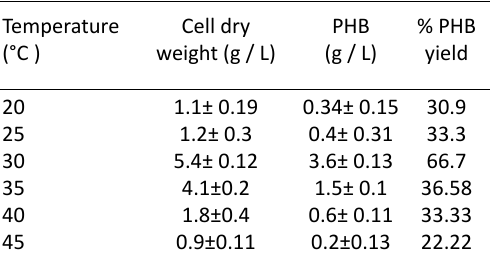
Table 6. Effect of temperature on production of PHB by Bacillus sp.